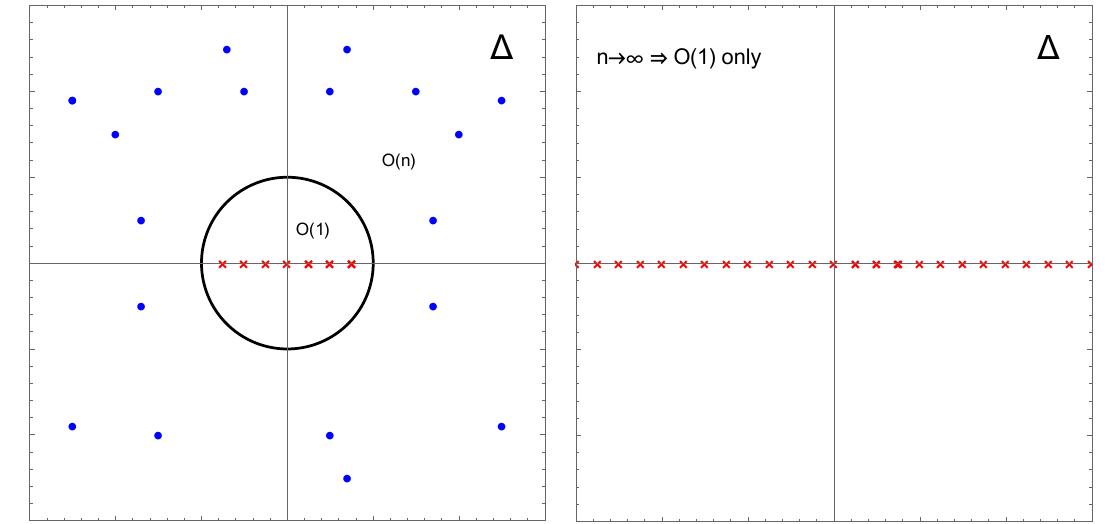
Figure 3 (a). A cartoon of poles in the (cid:1) plane. Figure 3 (b). A cartoon of the poles in the large D = n (cid:0) 3 limit of the (cid:1)